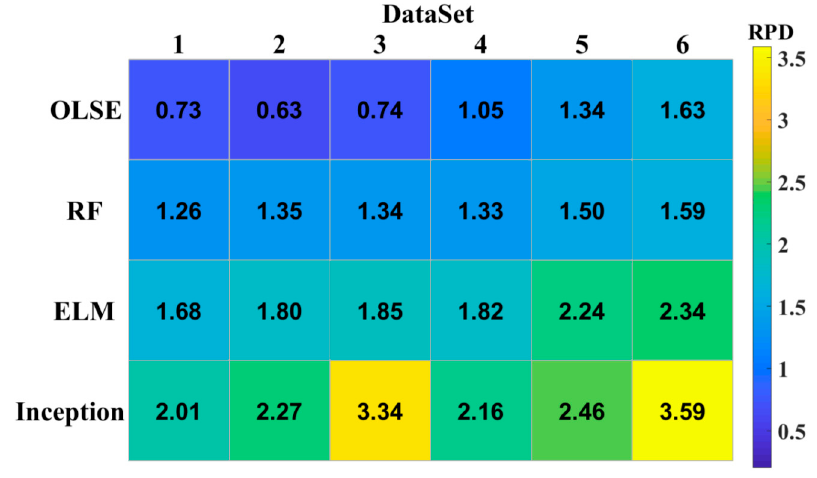
Figure 7. Effects of different predicted models with different size datasets. Figure 7. E ff ects of di ff erent predicted models with di ff erent size